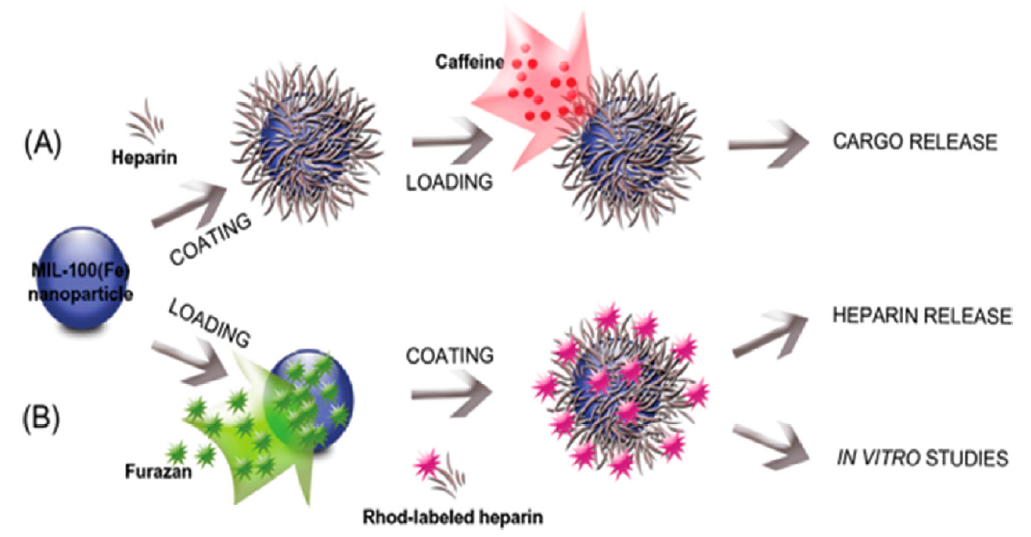
Figure 3. Schematic illustration of the formation of heparin-coated MIL-100(Fe) nanoparticles loaded with specific cargoes via two different pathways: ( A ) Heparin is selectively coated on the external surface of the NP followed by the post loading with caffeine; and ( B ) preloading with furazan followed by external coating of the NP with rhodamine-labeled heparin. Reproduced with permission from Ref. [113] Copyright 2015, John Wiley & sons.